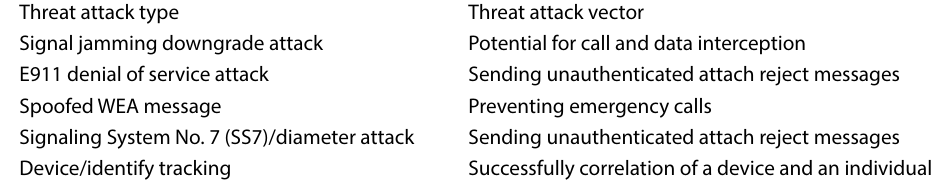
Table 1 Threat attack